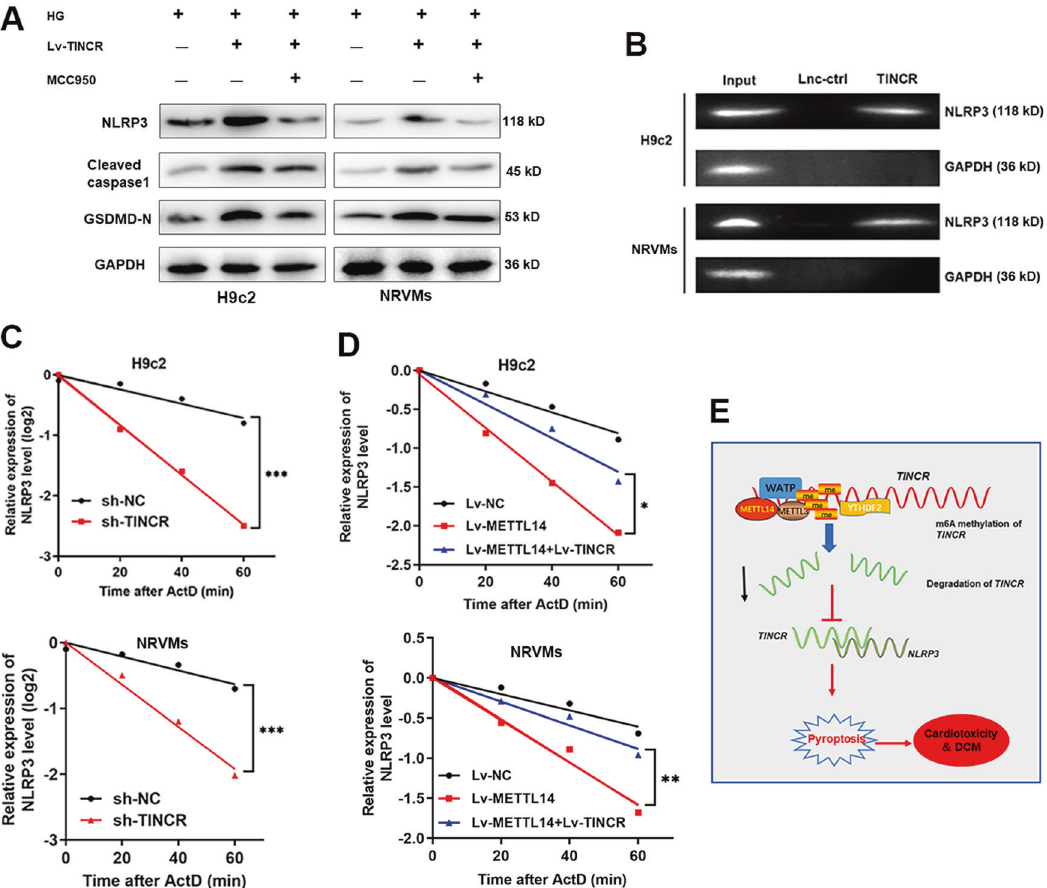
Fig. 7 TINCR functions through stabilizing NLRP3 mRNA. A Western blot experiment was performed to test the expression of pyroptosis- related proteins in cardiomyocytes treated with Lv-TINCR and MCC950. B RNA pulldown using speci fi c TINCR probe revealed a direct interaction between TINCR and NLRP3. C Cells were treated with ActD, then existing NLRP3 mRNA was detected at different time point. Silence of TINCR signi fi cantly decreased NLRP3 stability, P < 0.001. D METTL14 suppressed NLRP3 stability, while co-transfection of